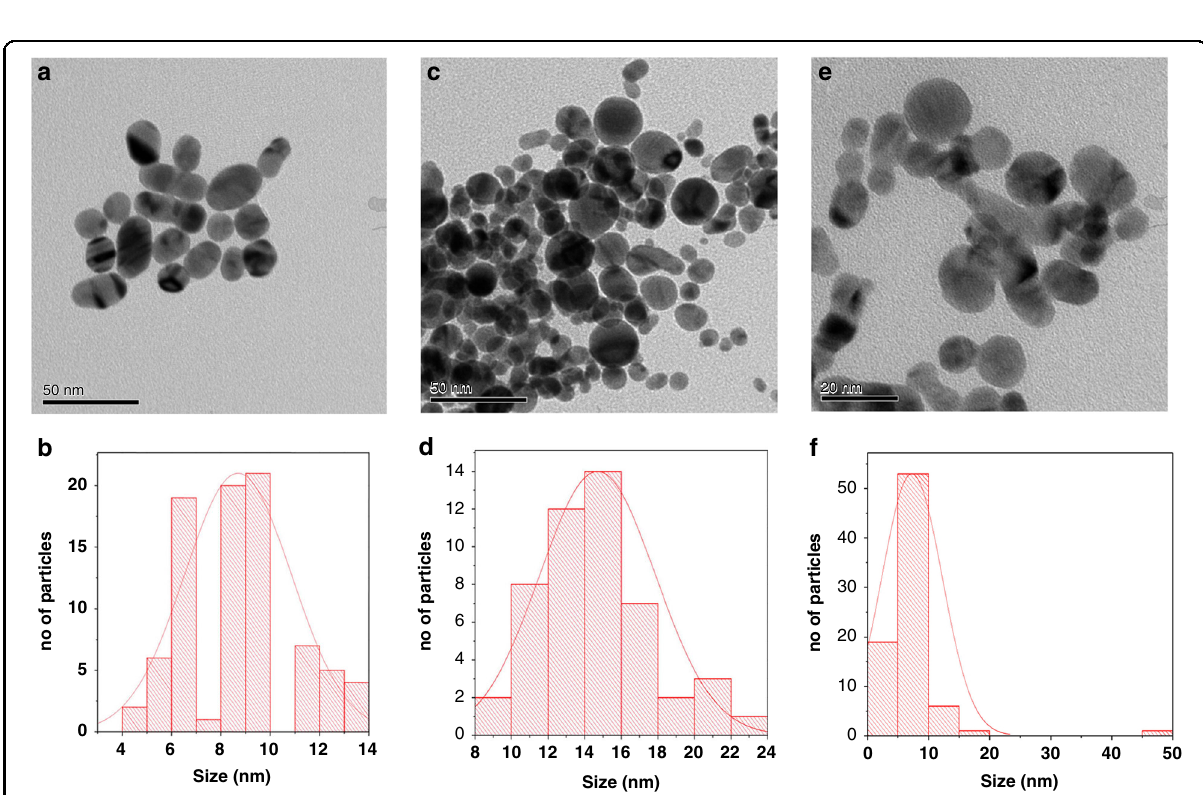
Fig. 5 TEM images and histograms of Au-NPs produced by ablation in water at various target positions. a , b above-focus, c , d at-focus, and e , f below-focus conditions 30 . Copyright (2021) Scienti fi c Research